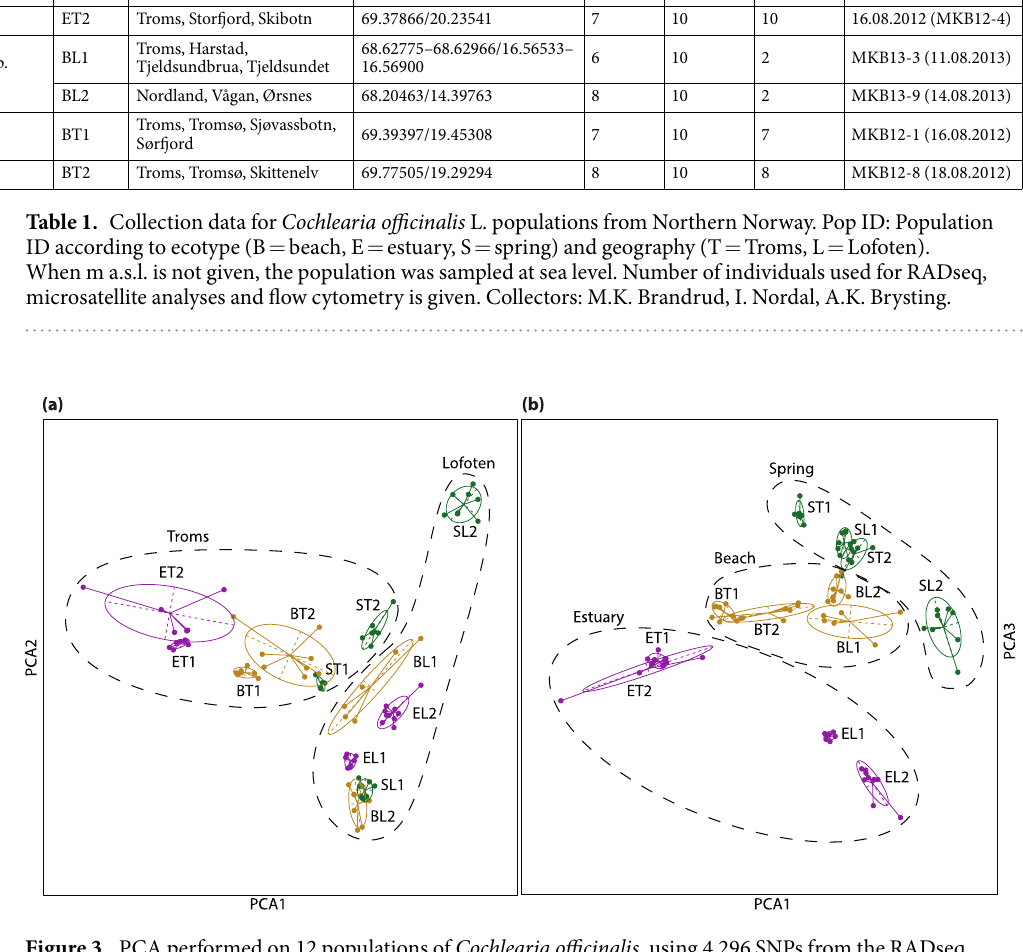
estuary populations in Lofoten allocated to a STRUCTURE group dominating among the beach populations in Lofoten (‘green’), whereas the estuary populations in Troms allocated to a STRUCTURE group dominating among the beach populations in Troms (‘purple’). The isolated spring population from Lofoten (SL2) was also in this analysis genetically the most distinct of all analysed populations, constituting a genetic group of its own (‘blue’), whereas the second spring population from Lofoten (SL1) was admixed and genetically similar to the beach populations from the same area.